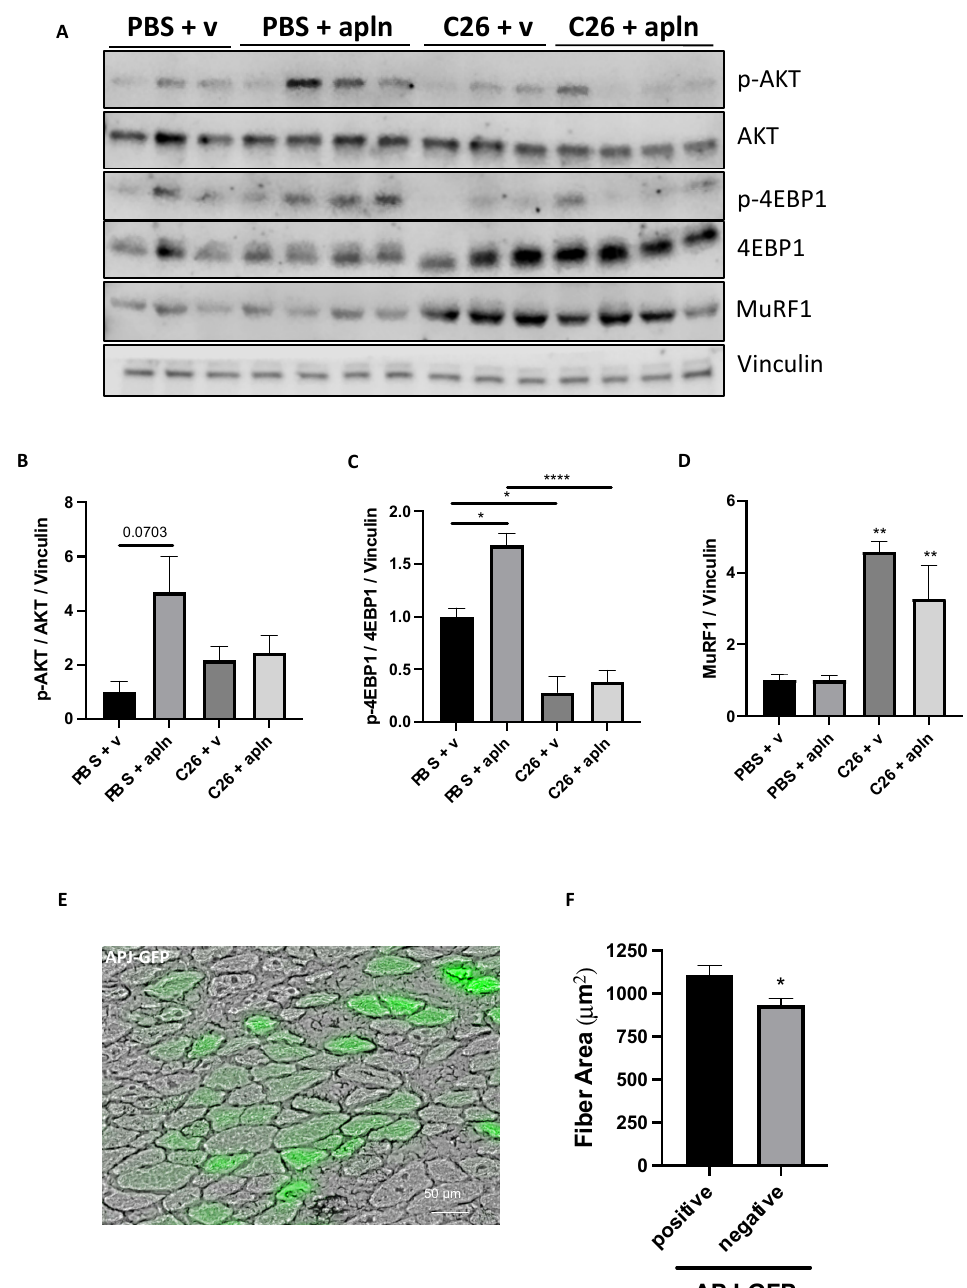
Figure 6. Muscles from mice with cancer cachexia display apelin resistance. Proteins from TA muscles of C26-carrying mice injected with preproapelin-expressing AAV9 were analyzed in Western blot for p-AKT, AKT, p-4EBP1, 4EBP1, MuRF1, and vinculin as loading control ( A ). Quantitations for p-AKT/AKT/vinculin ( B ), p-4EBP1/4EBP1/vinculin ( C ), and MuRF1/vinculin ( D ) are shown. Ordinary one-way ANOVA, Tukey’s multiple comparison test, * p ≤ 0.05, ** p ≤ 0.01, **** p ≤ 0.0001, n = 3–4. The APJ-GFP-encoding plasmid was electroporated for 14 days in mice that were injected with C26 tumor cells the day after. A representative image is shown ( E ). Scale bar, 50 µ m. At sacrifice, TA were dissected, frozen, and cut and the mean fiber CSA of APJ-GFP-expressing fibers was found bigger than that of adjacent non-expressing ones ( F ). Unpaired t -test, Mann–Whitney test, * p ≤ 0.05, seven mice and 89 fibers. Finally, to understand whether APJ was rate-limiting during muscle wasting in can- cer, we electroporated a plasmid encoding for APJ-GFP in TA muscle. The fluorescence